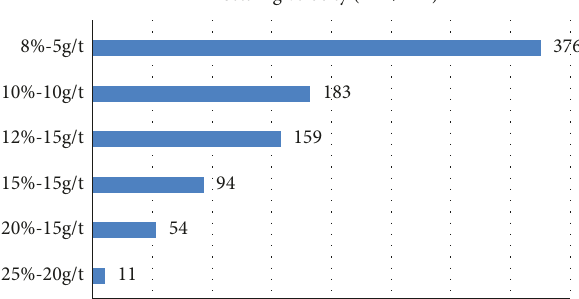
Figure 5: Settlement